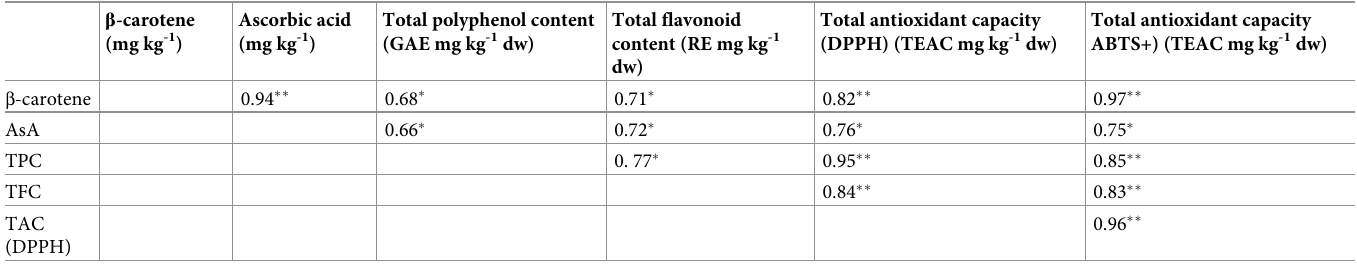
Table 4. Correlation coefficient for antioxidant phytochemical and antioxidant capacity in three selected A . tricolor accessions. β -carotene (mg kg -1